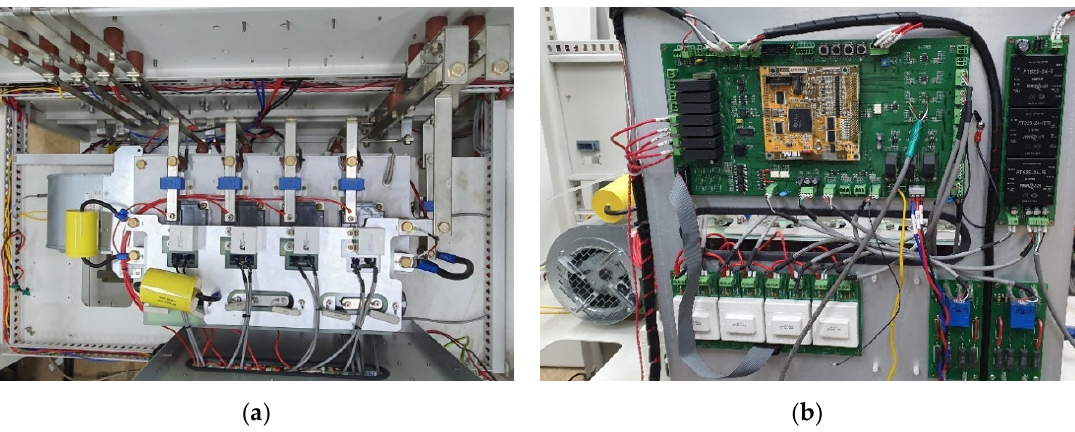
Figure 4. Photograph of three-phase 4-leg inverter: ( a ) Power stage; ( b ) controller. Table 1. Specifications of three-phase 4-leg